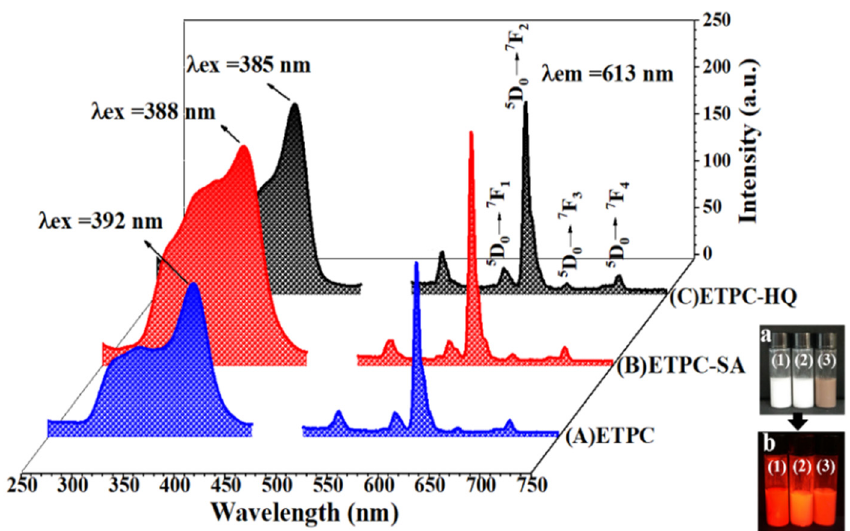
Figure 6. Photophysical properties of CLCCs. The spectra of groups A, B, and C are excitation and emission spectra corresponding to ETPC, ETPC-SA, and ETPC-HQ, respectively. The pictures at the low right side are three CLCC samples, namely, (1) EPPC, (2) ETPC-SA, and (3) ETPC-HQ, in each picture. Original samples under natural room light are displayed in ( a ), and the emission samples under UV irradiation are displayed in ( b ).